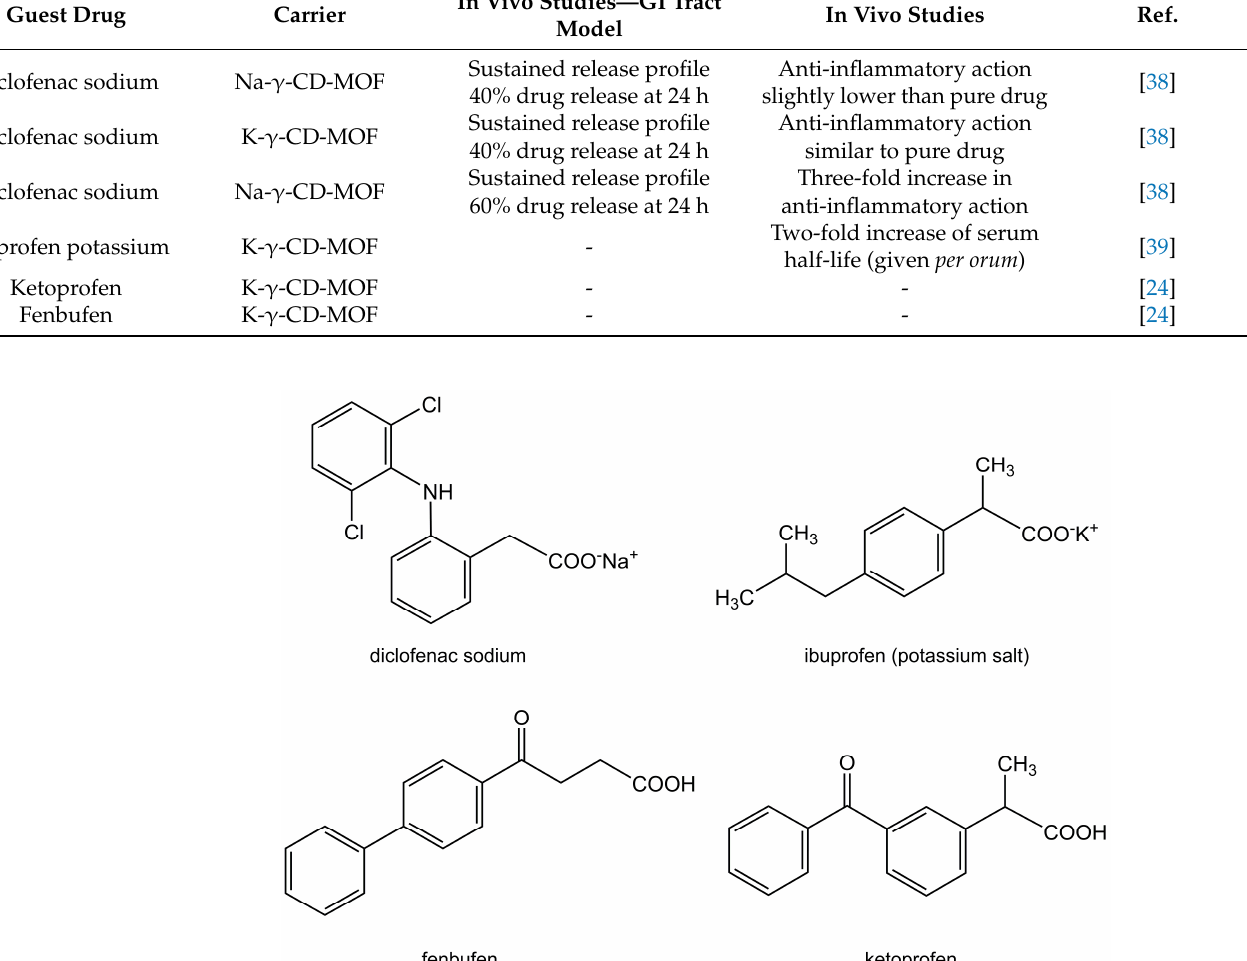
Figure 4. Overview of the non-steroidal anti-inflammatory drugs (NSAIDs) that have been successfully loaded into γ-CD-MOFs.